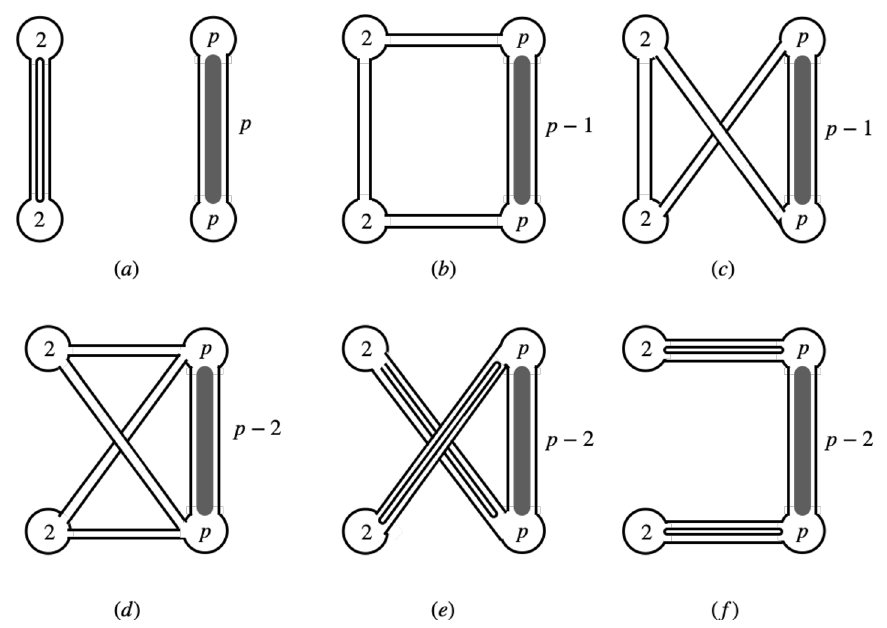
Figure 2 . Di(cid:11)erent Wick contractions for h O SG Wick contractions of any number of strands indicated by the number beside